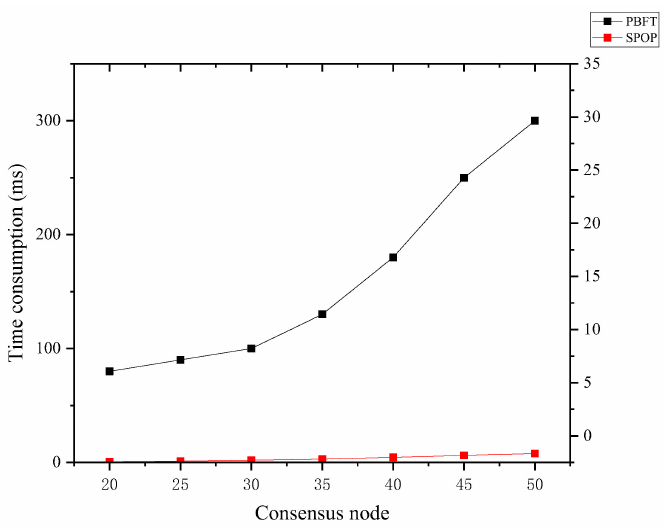
Figure 7. Comparison of consensus time consumption of SPOP consensus algorithm.